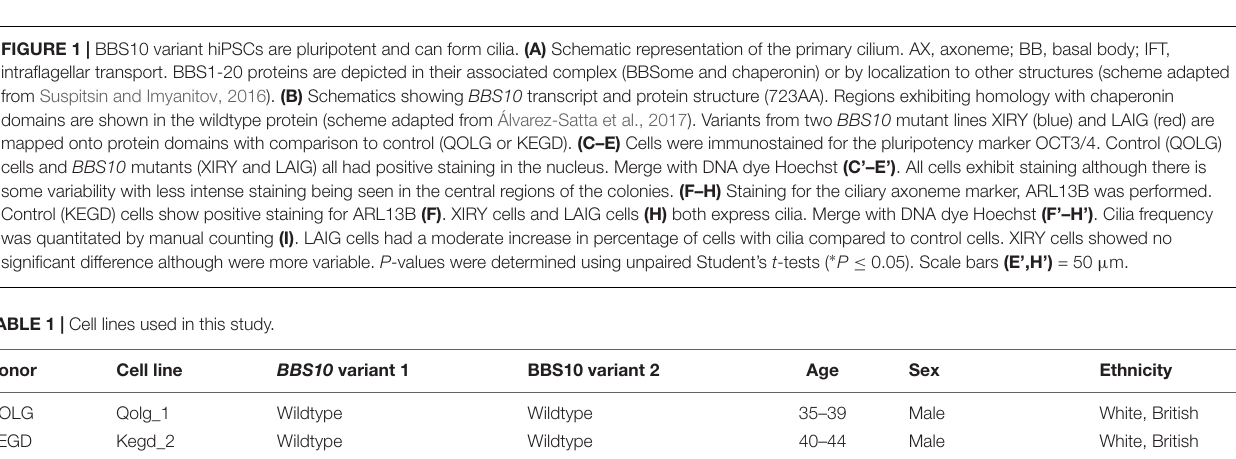
TABLE 1 | Cell lines used in this study.